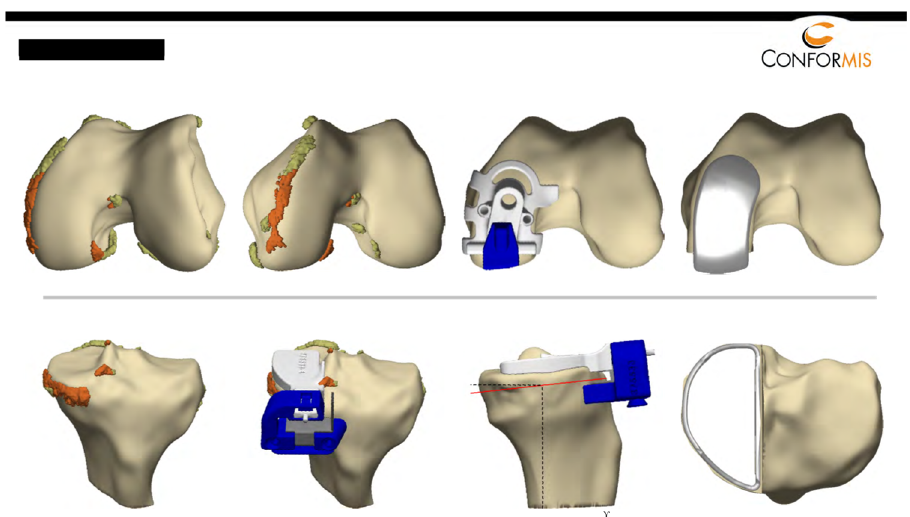
Figure 1. Preoperative planning of the prosthesis and surgical guide (Iview) delivered for every patient. It shows the osteophytes that must be removed to position the patient-specific instruments (orange-colored). The position of the patient-specific instruments is also shown. In particular, the position of the femoral jig in accordance with the femoral component is very helpful for the surgeon. Furthermore, it shows the final position of the prosthesis (see further details in the text).